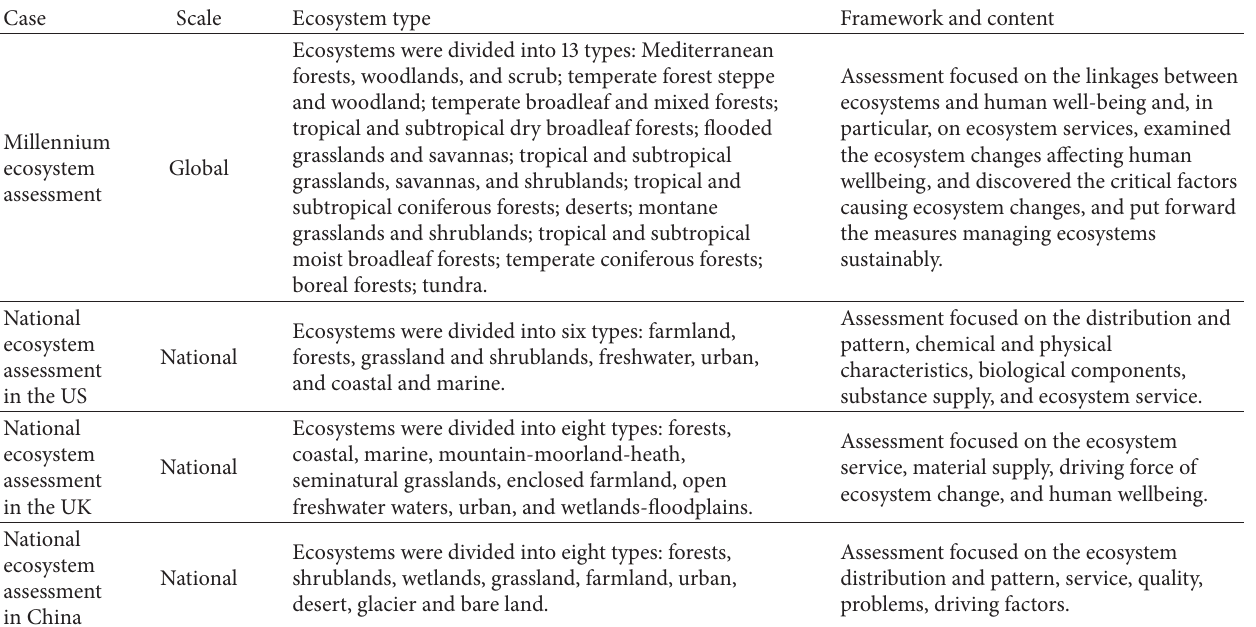
Table 1: Comparative list of classical cases of integrated